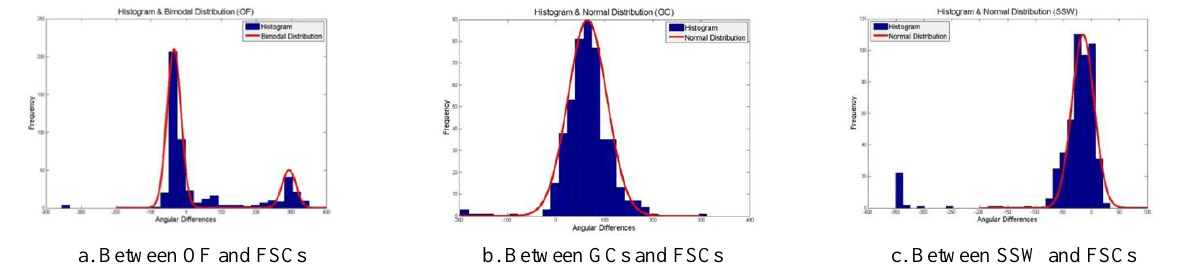
Figure 9. Normal and bimodal histograms and distributions for angular differences between FSCs and OF, GCs and SSW